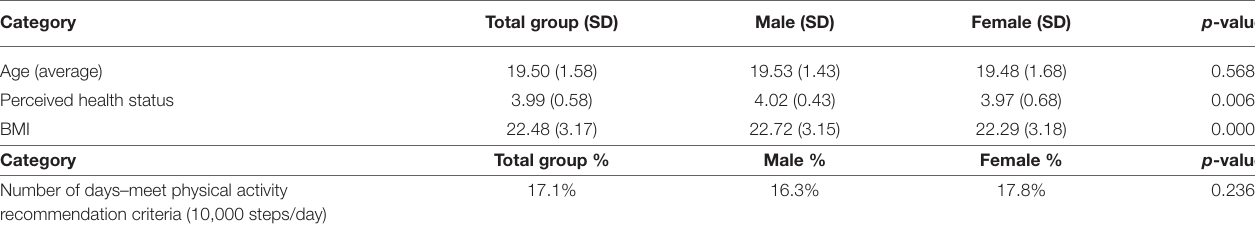
TABLE 2 | Characteristics of the voluntary university